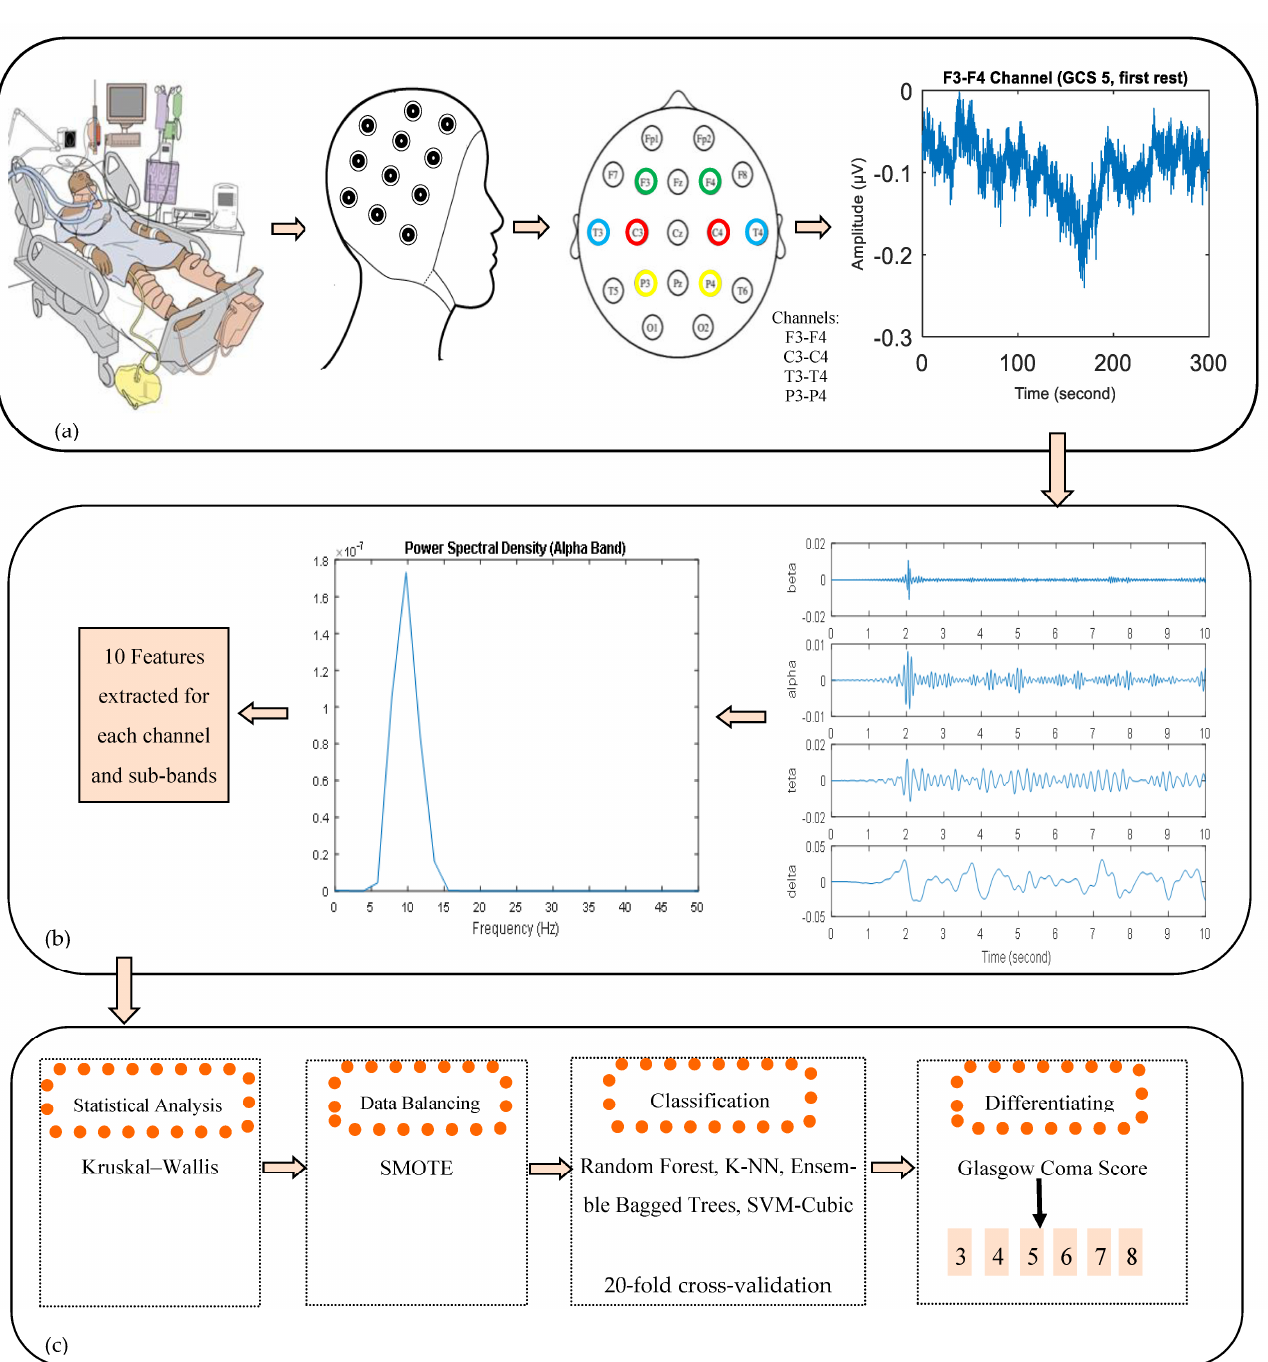
Figure 6. The main blocks of the presented methodology: ( a ) data acquisition and EEG recordings, ( b ) pre-processing and feature extraction, and ( c ) statistical analysis and classi fi cation.